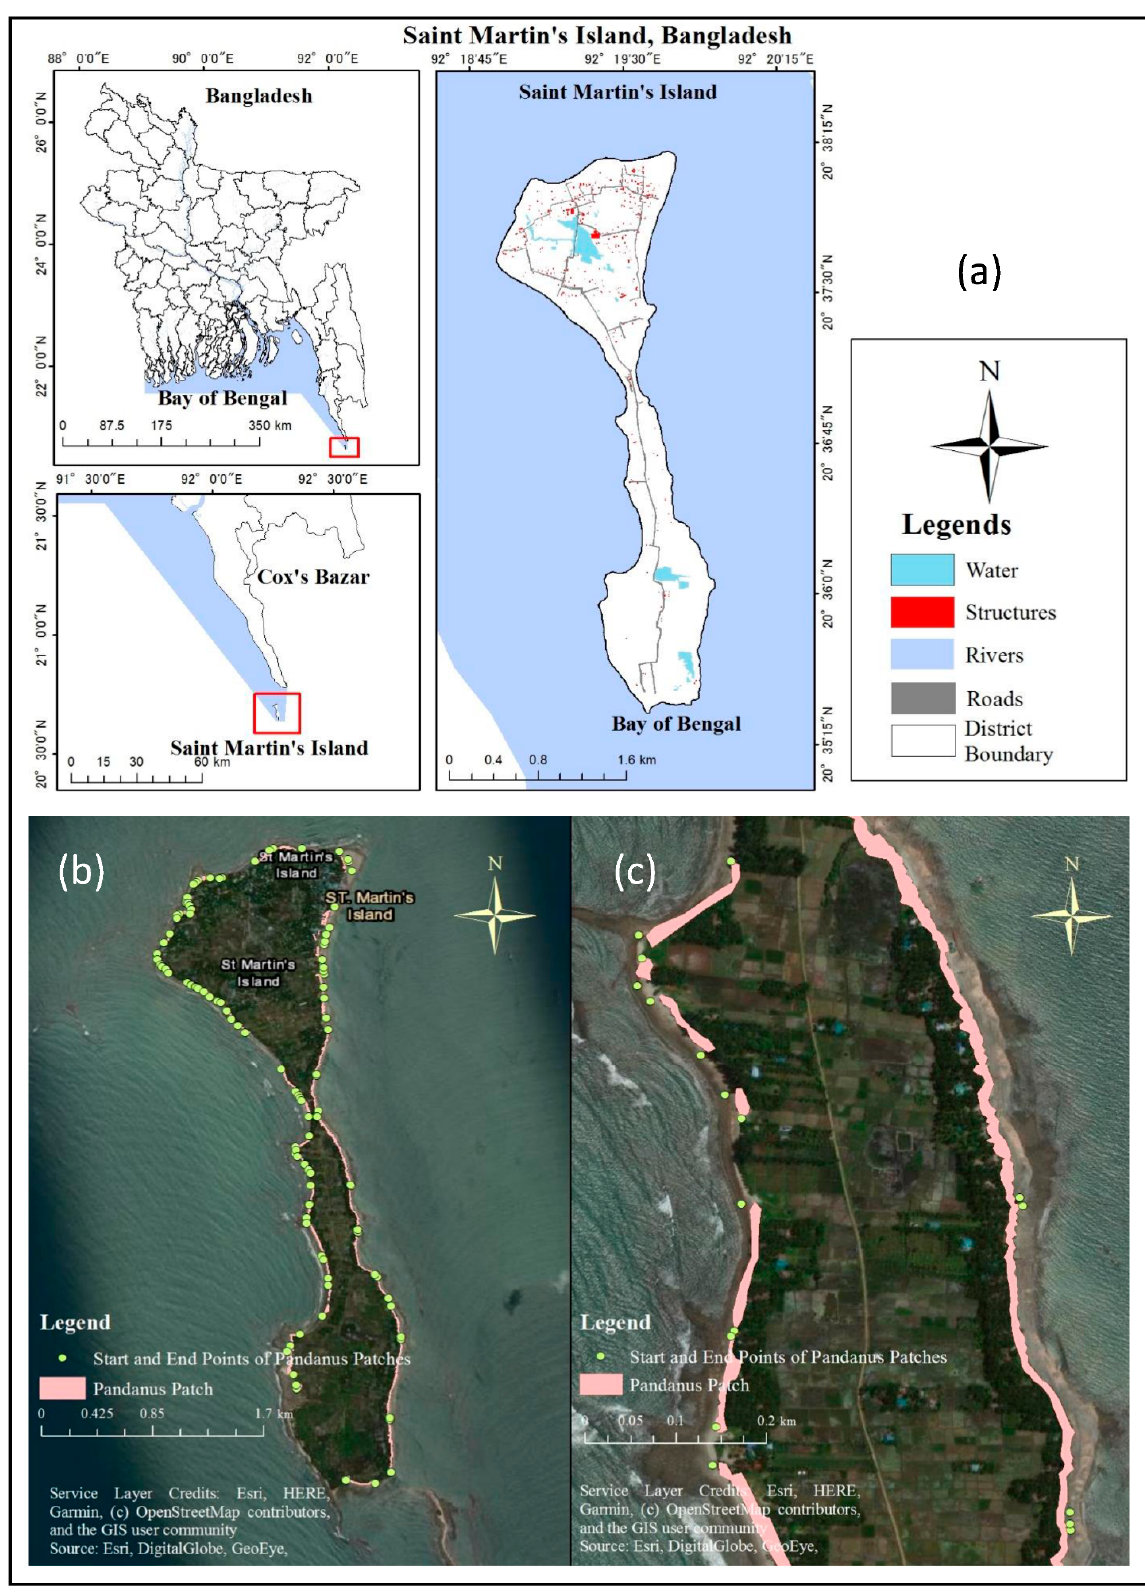
Figure 1. ( a ) Location of Saint Martin’s Island. ( b ) Location of Pandanus trees on Saint Martin’s Island. ( c ) Pandanus patches are located in the colored part ( b , c ): ArcGIS Satellite Base Map (edited on 20 May 2022).